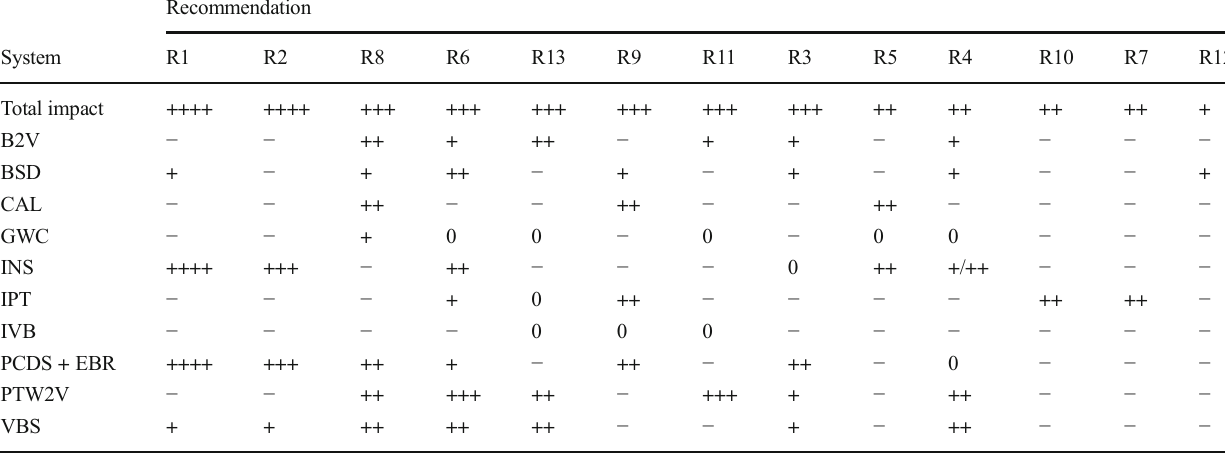
(R3) and efficient user interfaces (R4) to achieve the desired reaction of the road user. Table 10 Results quantitative analysis